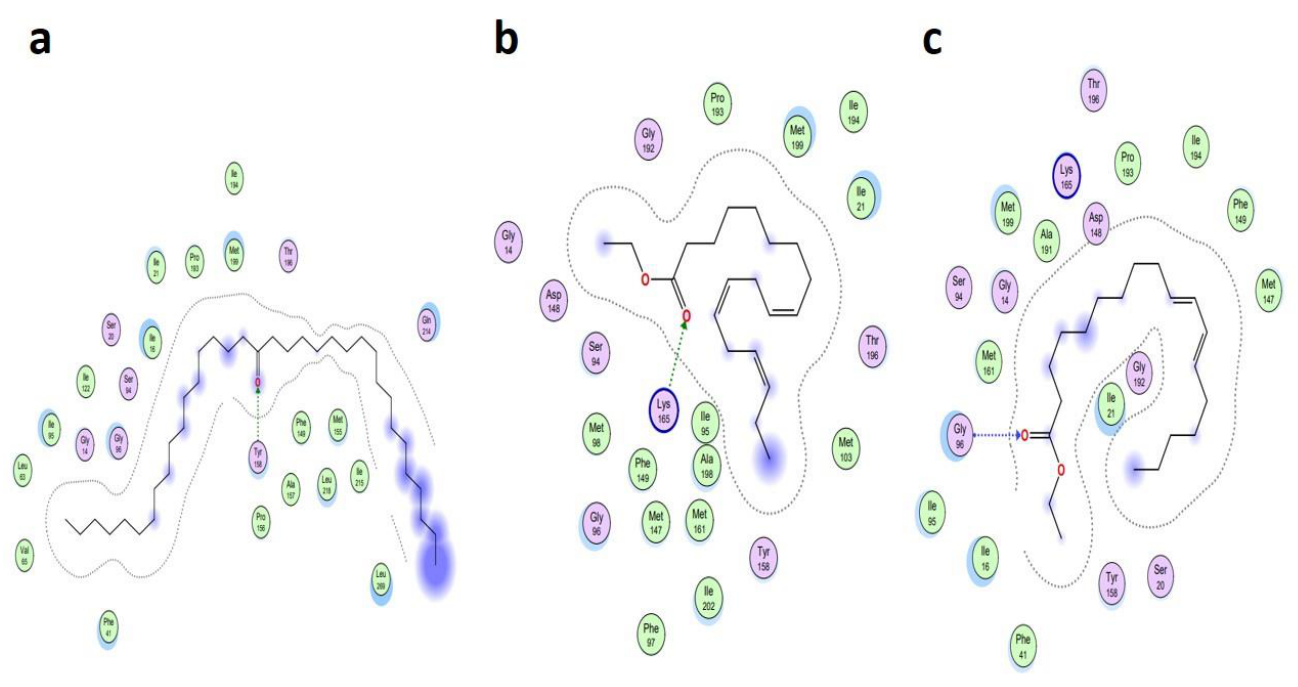
Figure 8. Hydrogen bonding capacity of top three scored docked ligands CID_ 22287839 ( a ), CID_10440 ( b ), and CID_5363633 ( c ), within the active site of antioxidant protein [PDB ID: 1HD2]. Purple colored area presents the hydrogen bond donor capacity and the green colored area presents the hydrogen bond acceptor capacity.